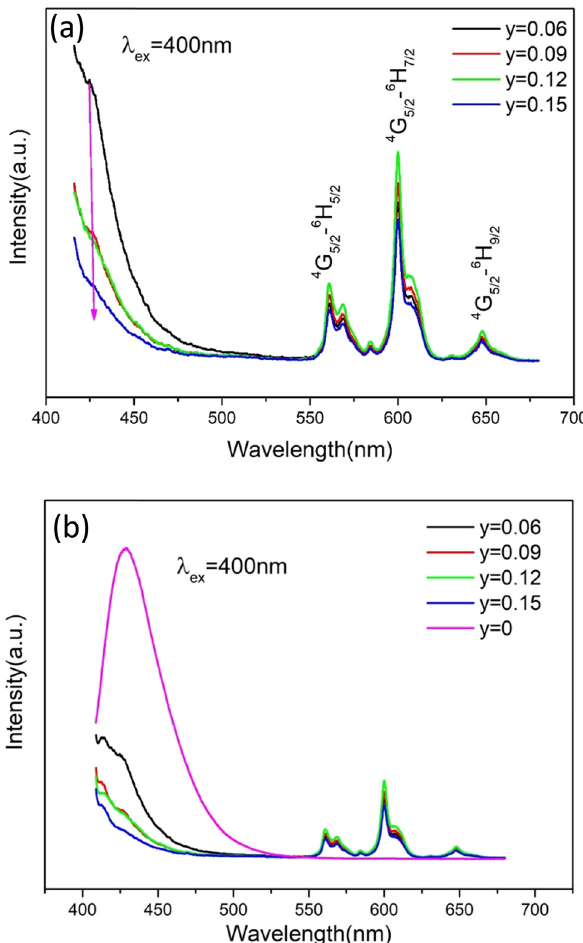
Figure 8: ( a ) PL spectrum of KBP:0.1% Eu 2 + / y Sm 3 + phosphors excited by 400 nm and ( b ) photoluminescence emission spectrum of KBP:0.1% Eu 2 + / y Sm 3 + phosphors ( y = 0, 0.06, 0.09, 0.12, 0.15 )